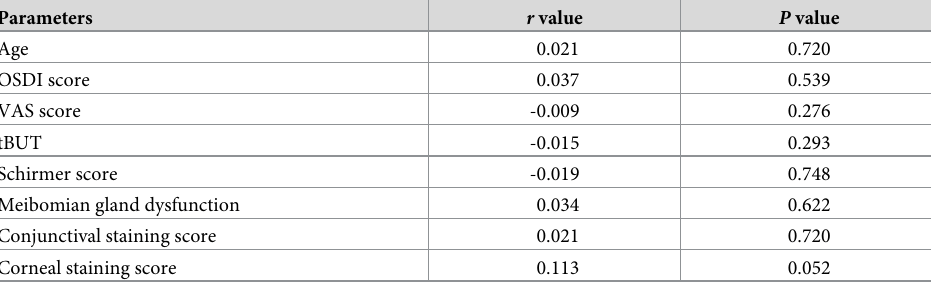
Table 6. Clinically significant associations with quantitative results of MMP-9 point-of-care test. Parameters r value Age